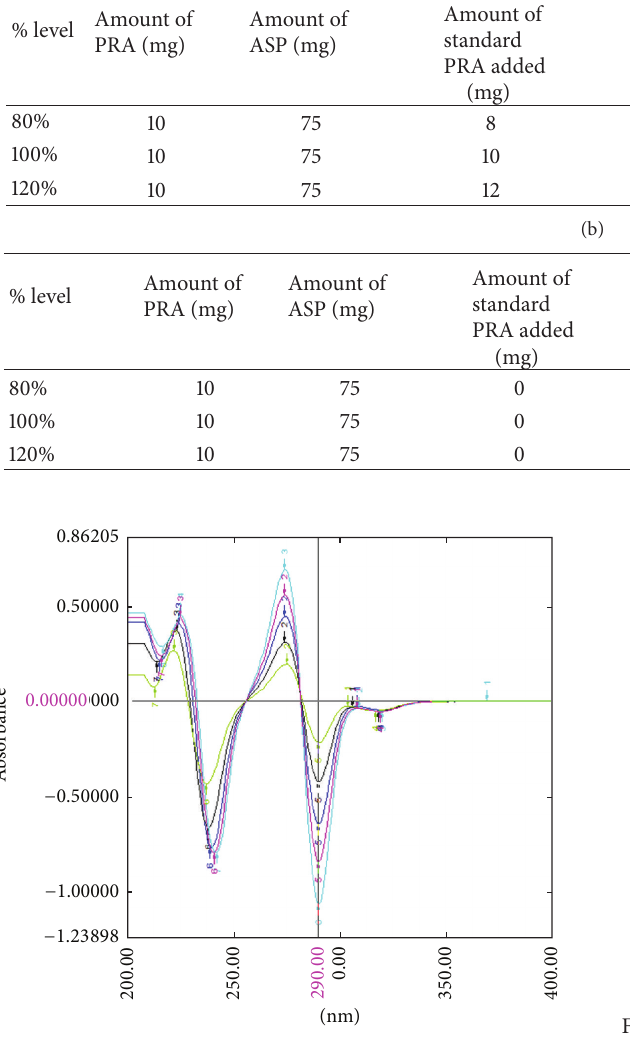
Figure 10: First derivative ratio spectra of ASP (45–165 𝜇 g/mL).